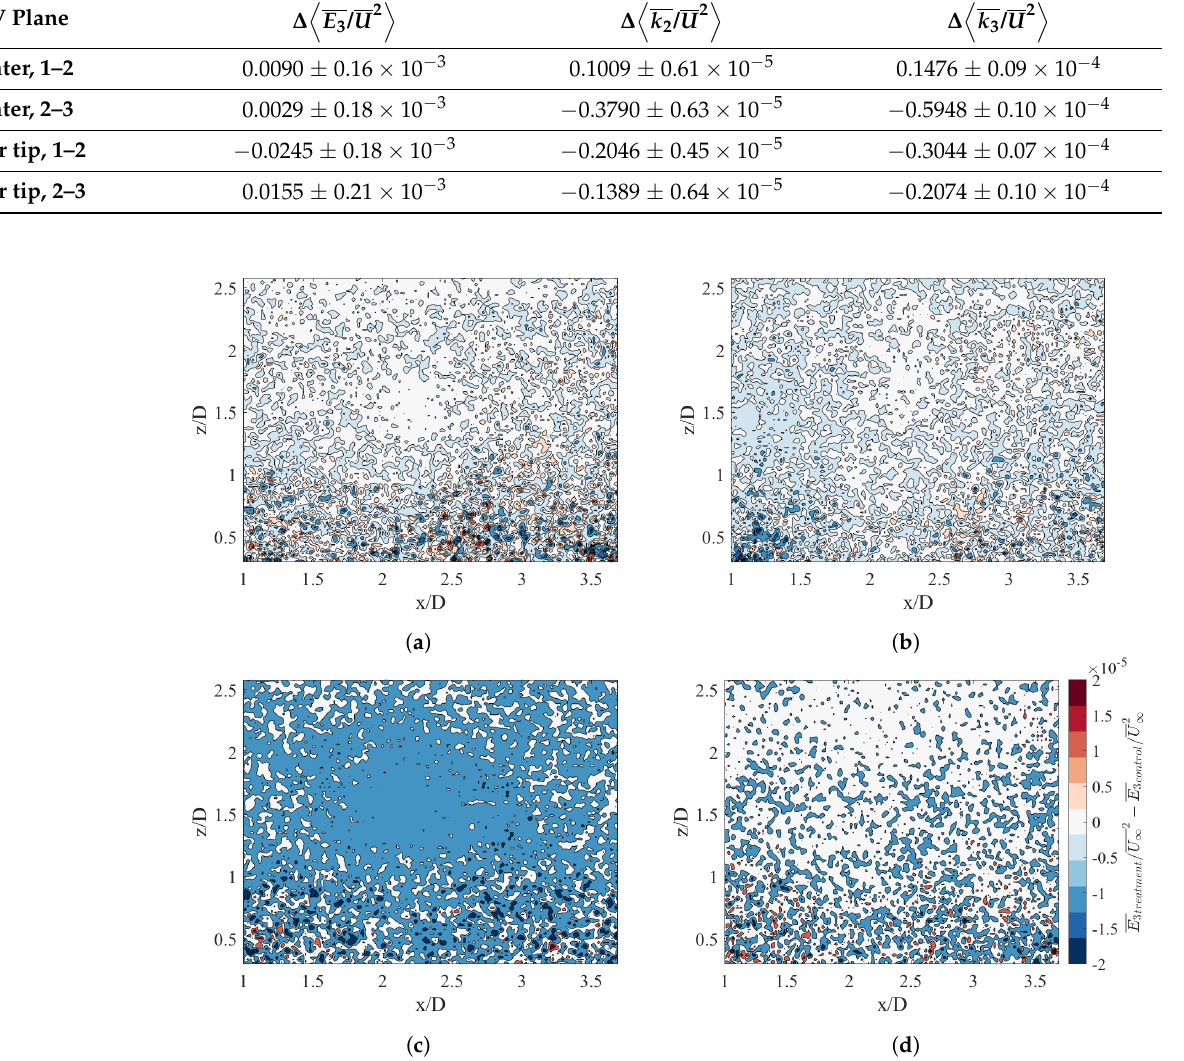
Figure 15. Differences between treatment and control of the MKE normalized by the freestream value: ( a ) centerline plane between rows one and two; ( b ) centerline plane between rows two and three; ( c ) rotor tip plane between rows one and two; and ( d ) rotor tip plane between rows two and